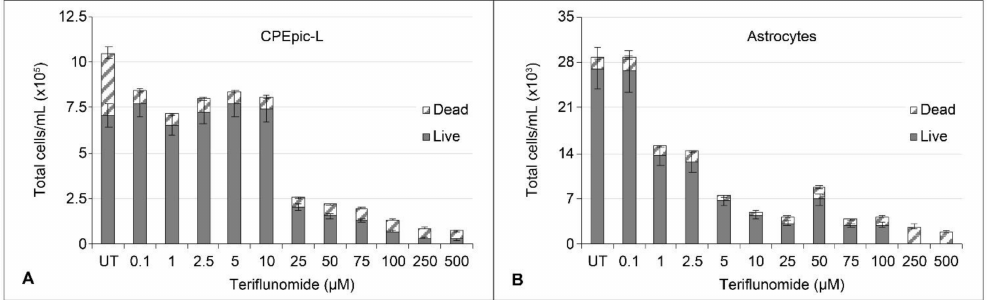
Figure 1. Live/dead cell counts of JCPyV-infected, teriflunomide-treated CPEpic-L ( A ), and primary astrocytes ( B ). Cells were pretreated, infected, and maintained in teriflunomide for 5 days. On Day 5, cells were collected using Cellstripper, stained with propidium iodide, and analyzed by flow cytometry for total live/dead cell counts. Volume-matched vehicle controls were run for each sample. There was a dose-dependent decrease in total cell number for all cell lines, and viability was maintained at all but the highest doses of teriflunomide. Bars represent the average of each sample count in triplicate. Error bars represent standard deviation. CPEpic-L = choroid plexus epithelial cells; JCPyV = JC